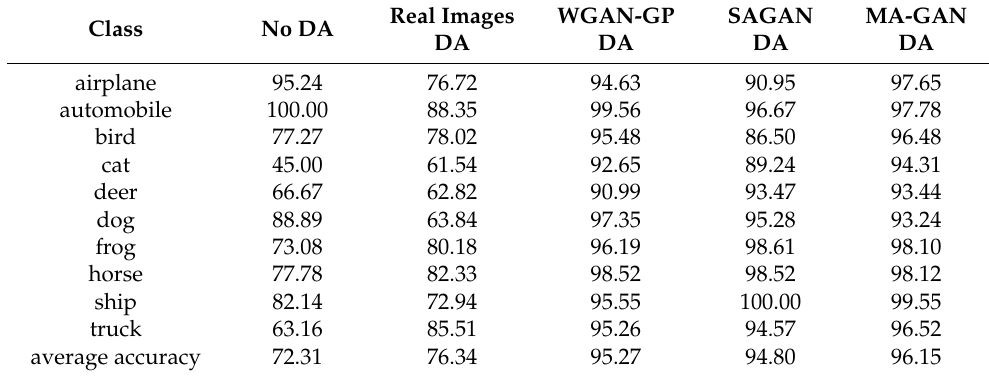
Table 12. Classified accuracy of CIFAR-10 training set after augmentation by different methods (%).